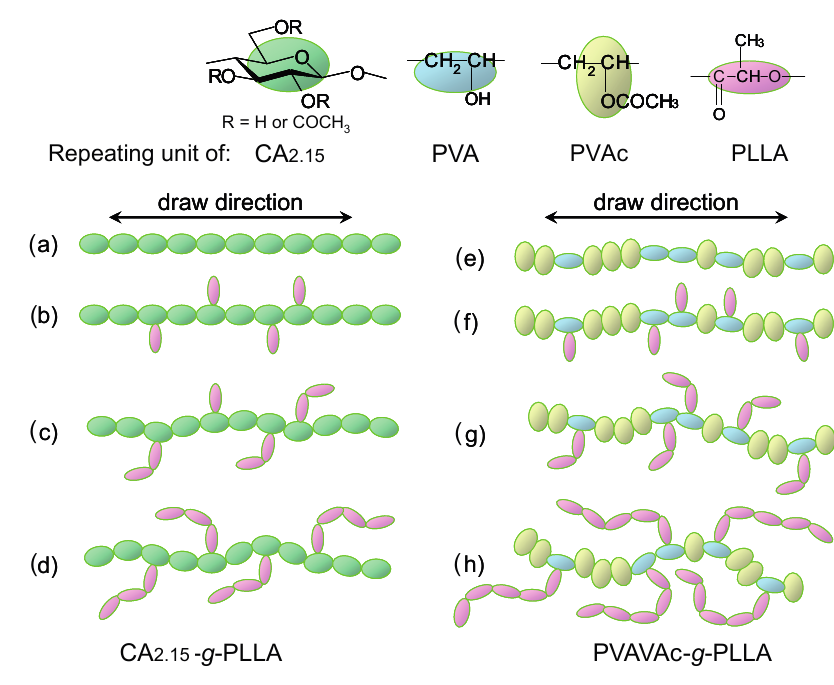
Figure 29. Birefringence plots of films comprising CA 2.15 - g -PLLA ( b ), PVAVAc- g -PLLA ( c ), and their component polymers and related ones ( a ) as a function of elongation. Numerals in (b) and (c) correspond to OH-MS values for graft copolymers. PVAVAc# is an additional copolymer presenting a VA/VAc molar ratio of 0.164/0.836. Reproduced with permission from ref. [72]. Copyright 2011 Springer Science + Business Media B.V.